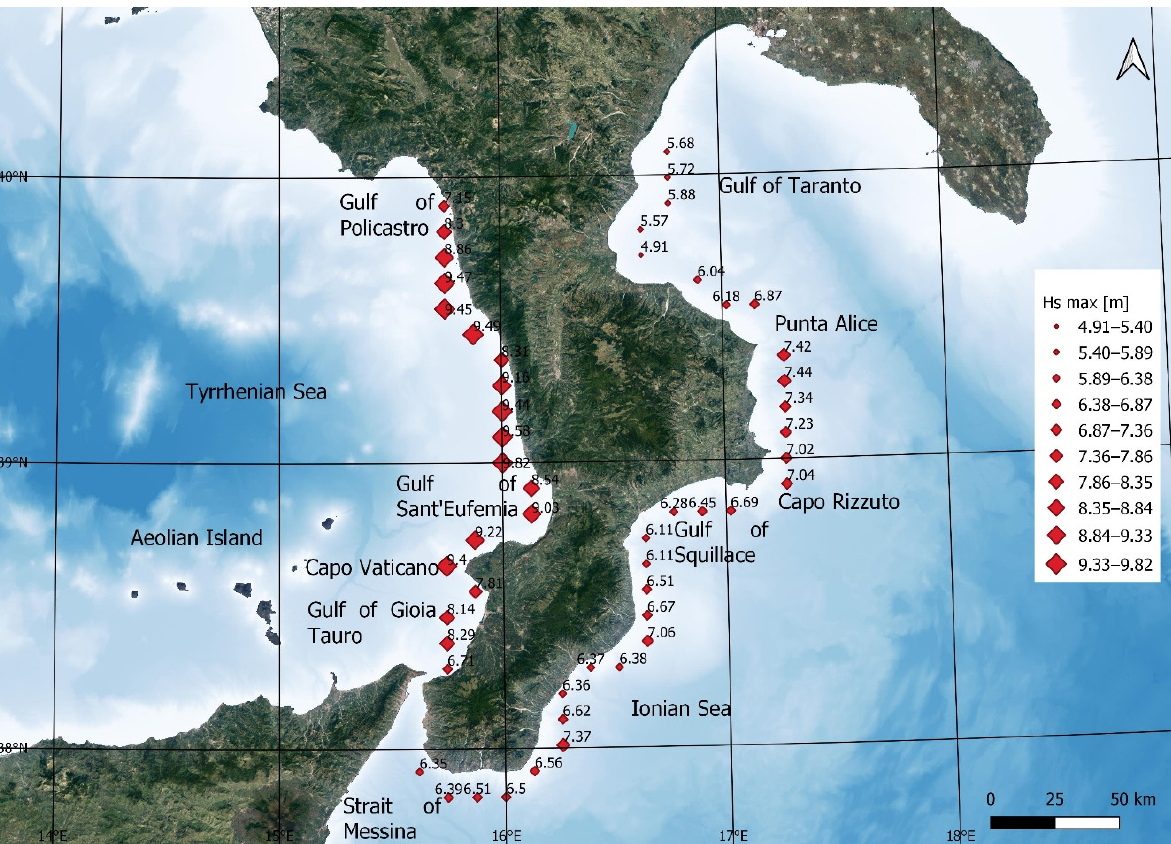
Figure 3. Maximum significant wave height h s , max values. The range between the minimum and the maximum values has been divided into 10 intervals of the same width.